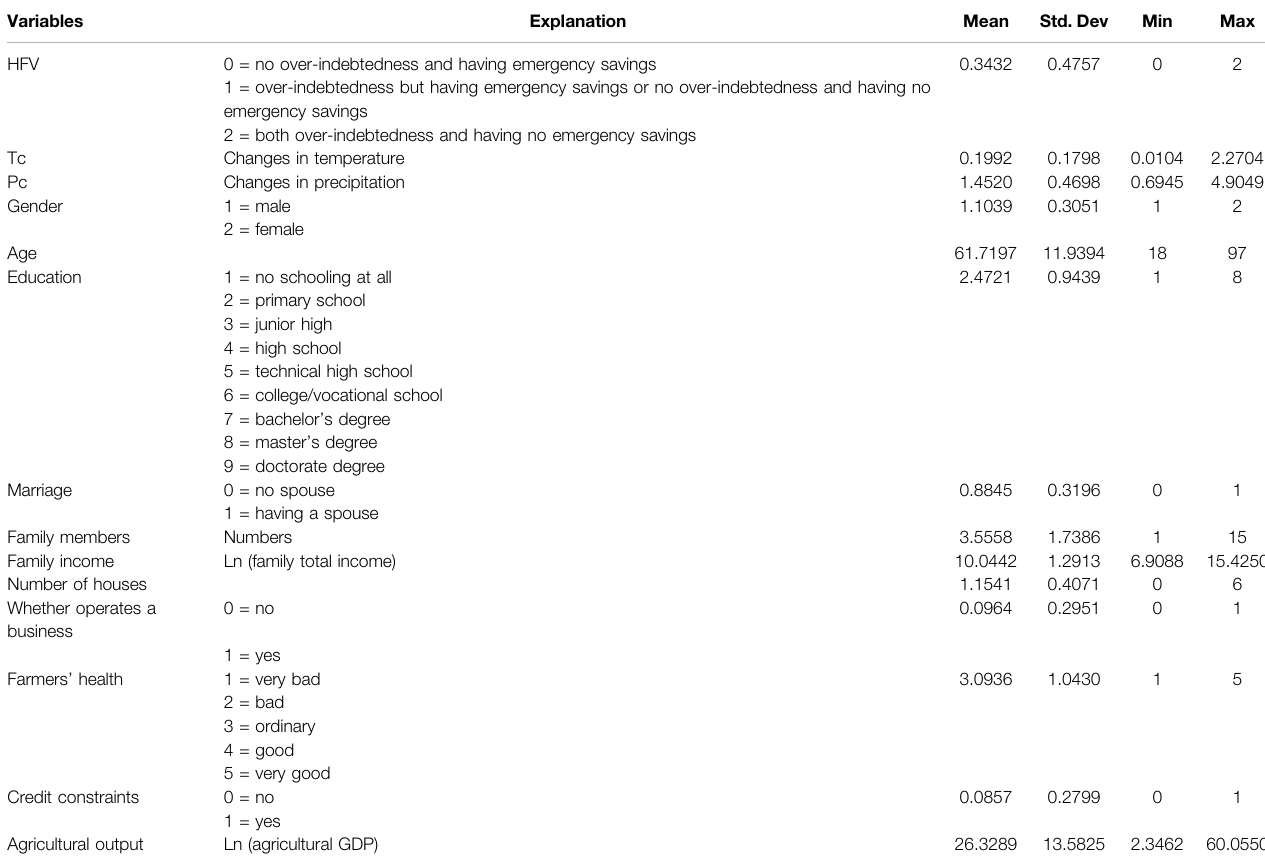
TABLE 1 | Descriptive